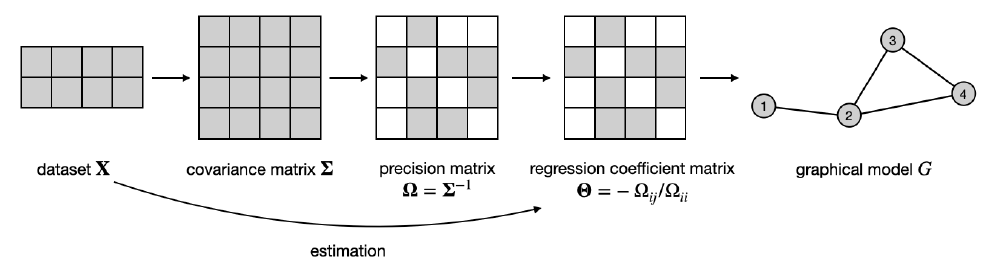
Figure 1. Idea of regression-based graphical model estimation for a single dataset X : estimate the regression coefficient matrix Θ from the data and use its support as an adjacency matrix of the graph G . See text for